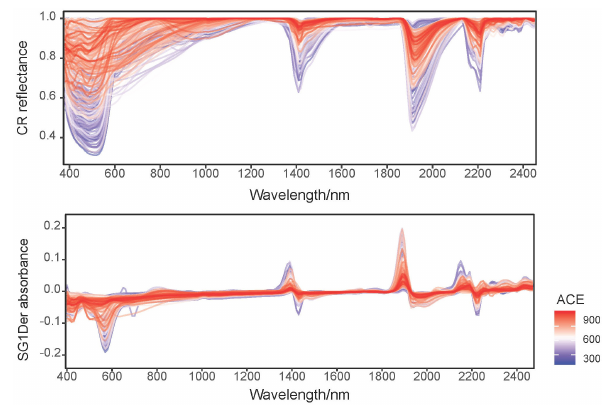
Figure 2. Continuum removed (CR) spectra and the Savitzky– Golay first derivatives (SG1Der) absorbance spectra curves coloured by fungal ACE